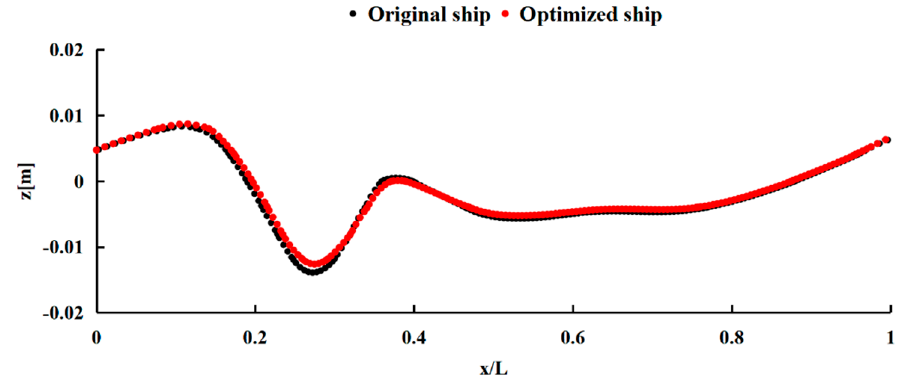
Figure 16. The profile of the wave profile along different ship models at y/L = 0.0984.